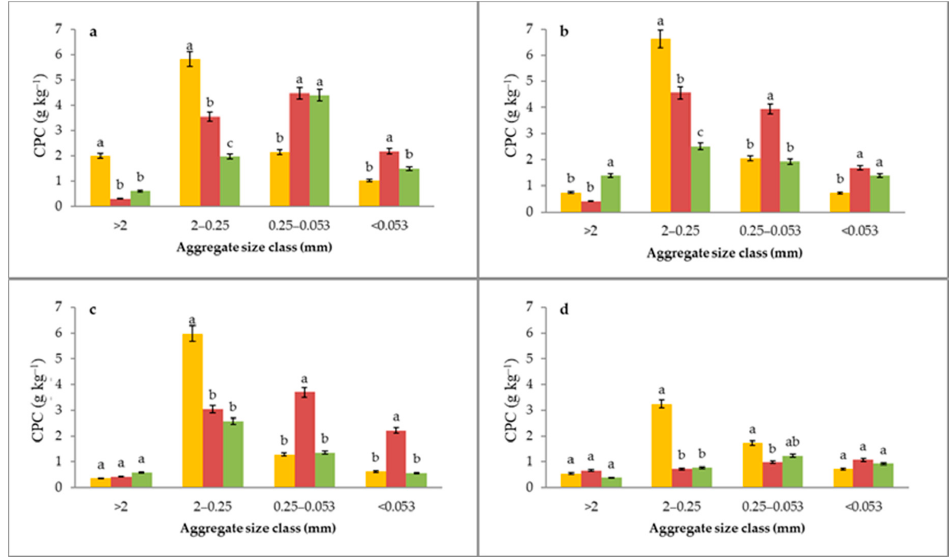
6 Figure 6. Soil organic carbon preservation capacity (CPC) in g kg − 1 in different sizes of aggregates for the initial situation (CT0; yellow bars), conventional-till (CT1; red bars) and no-till (NT+H; green bars) treatments at different horizons for ( a ) Ap horizon, ( b ) Bw horizon, ( c ) BC horizon and ( d ) C horizons. Values are given as mean ± standard error (n = 5). The different lowercase letters above the error bars for the same aggregate fraction indicate significant differences based on post-hoc tests, Tukey’s honestly significant difference (HSD) at p < 0.05 between